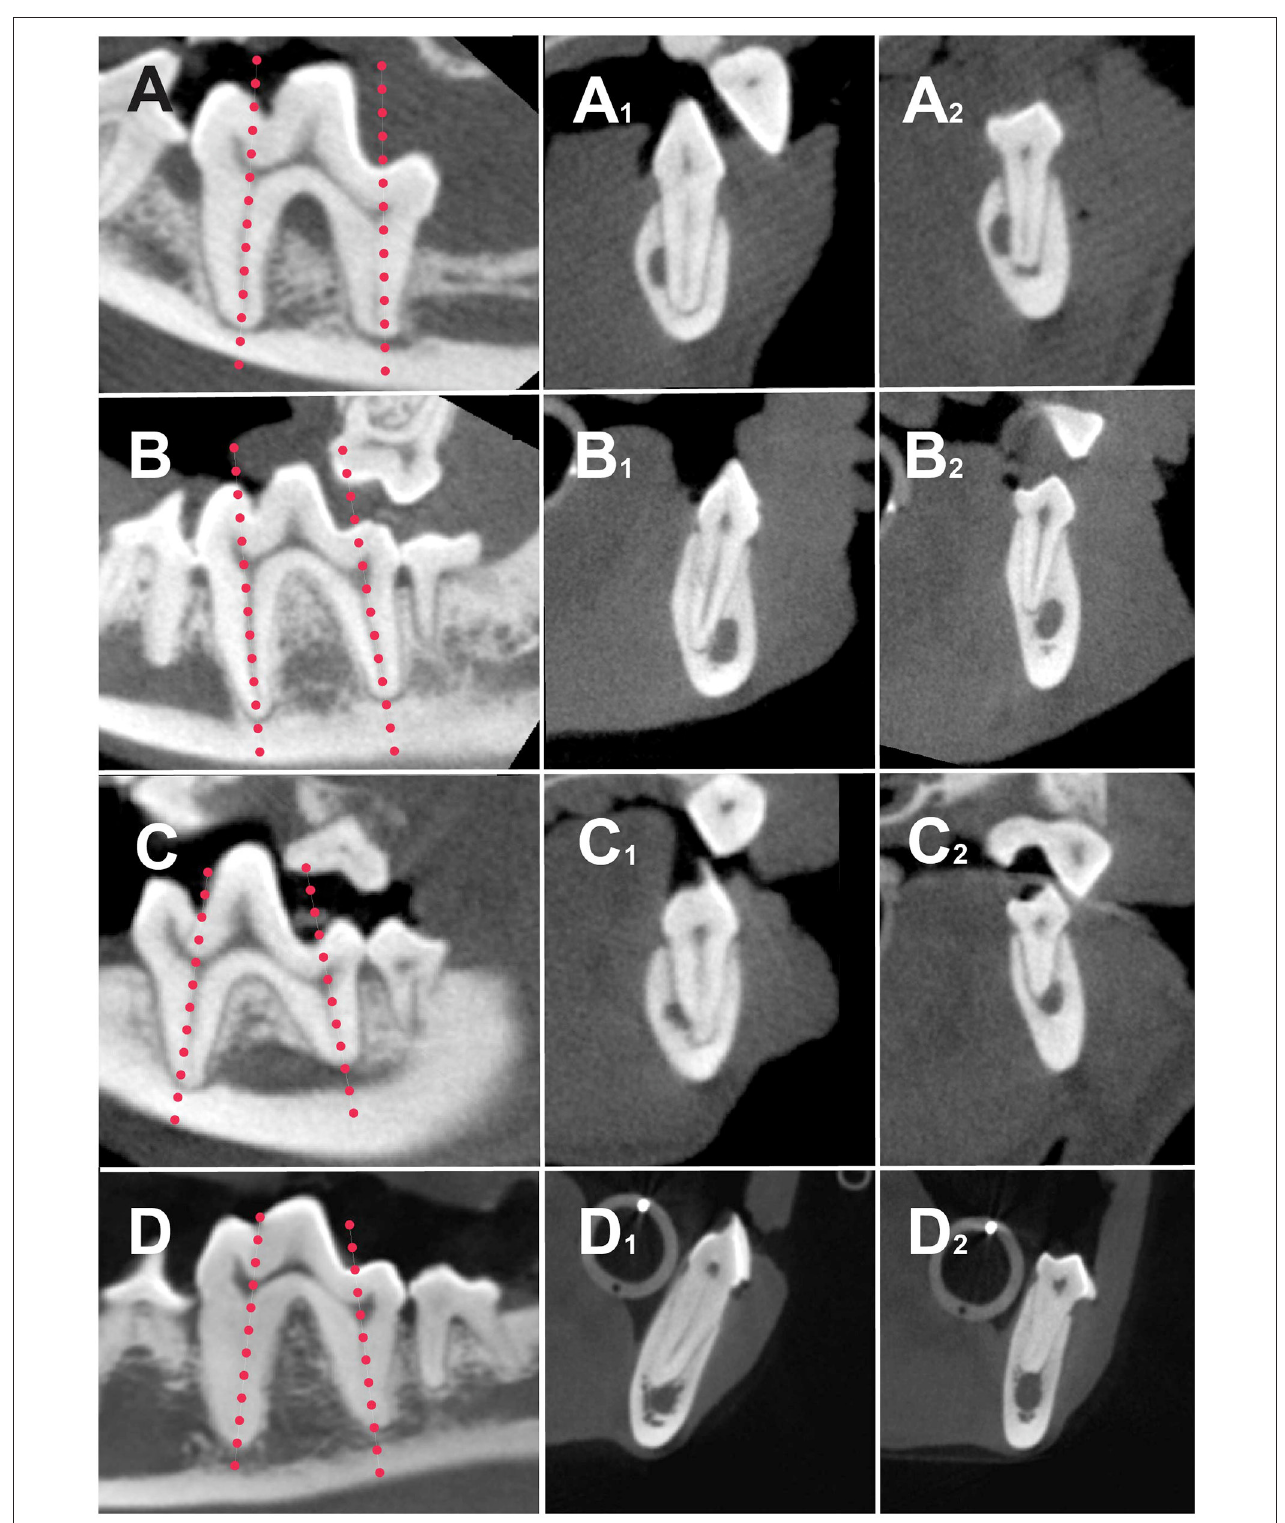
FIGURE 2 | Sagittal (A–D) and transversal high-definition computed tomography (HDCT) reconstructions of the mesial (A 1 -D 1 ) and distal roots (A 2 -D 2 ) of different dogs showing different root localization. Dotted lines on (A–D) show the axis of the roots for the transversal reconstructions. (A 1 ,A 2 ) Both mesial and distal roots are located on buccal side of the mandibular canal (MC). (B 1 ,B 2 ) Both mesial and buccal roots are located on lingual side of MC. (C 1 ,C 2 ) Straddle tooth. (C 1 ) Mesial root buccal to the MC; (C 2 ) distal root lingual to the MC; (D 1 ) mesial root lingually located; (D 2 ) distal root dorsally located.